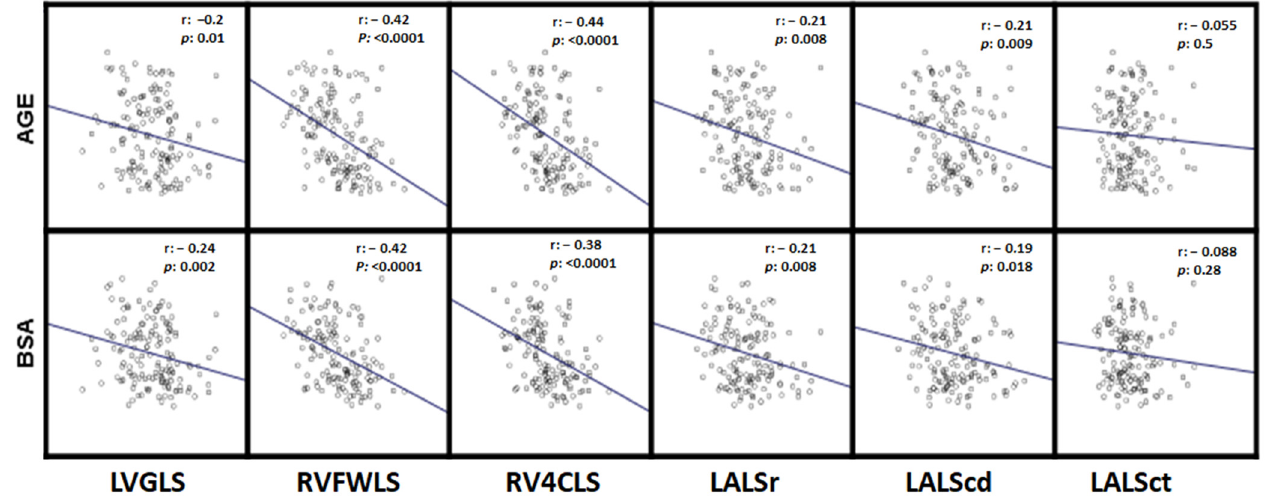
Figure 2. Scatter plots for correlations of strain values with age and BSA. Body surface. r, The Pearson correlation coefficient; the regression slope is displayed in blue. LVGLS: Left ventricle global longitudinal strain, RVFWLS: Right ventricle free wall longitudinal strain, RV4CLS: Right ventricle four chamber longitudinal strain, LALSr: Left atrial longitudinal strain reservoir phase, LALScd: Left atrial longitudinal strain conduct phase, LALSct: Left atrial longitudinal strain contraction phase.